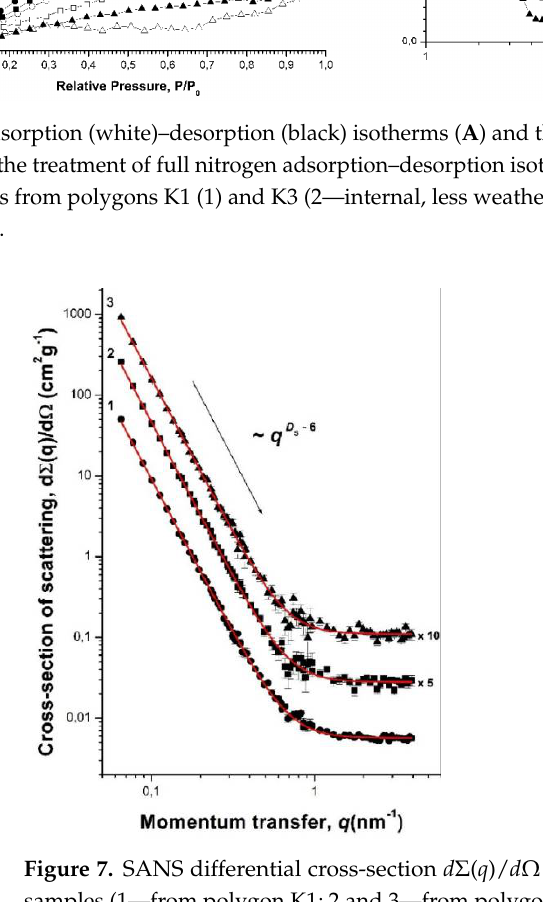
Figure 6. Full nitrogen adsorption (white)–desorption (black) isotherms ( A ) and their correspond- ing pore size distributions d V( D) ( B ) obtained from the treatment of full nitrogen adsorption–de- sorption isotherms within the BJH model: (here and in Figure 7) moraine samples from polygons K1 (1) and K3 (2—internal, less weathered part; and 3—surface, more weathered part of the same boulder). Table 1. Parameters of the mesostructure of the moraine samples obtained from the analysis of SANS ( D S = 6 − n ) and low- temperature nitrogen absorption data ( S BET, d p, and V P / P 0  0.99 ).